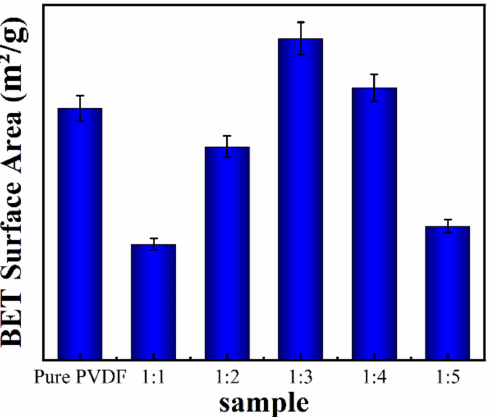
Figure 2. BET surface area of the electrospinning pure PVDF membrane and the ZnO@PVDF composite membranes with mass ratios of ZnO:PVDF = 1:1, 1:2, 1:3, 1:4, and 1:5,